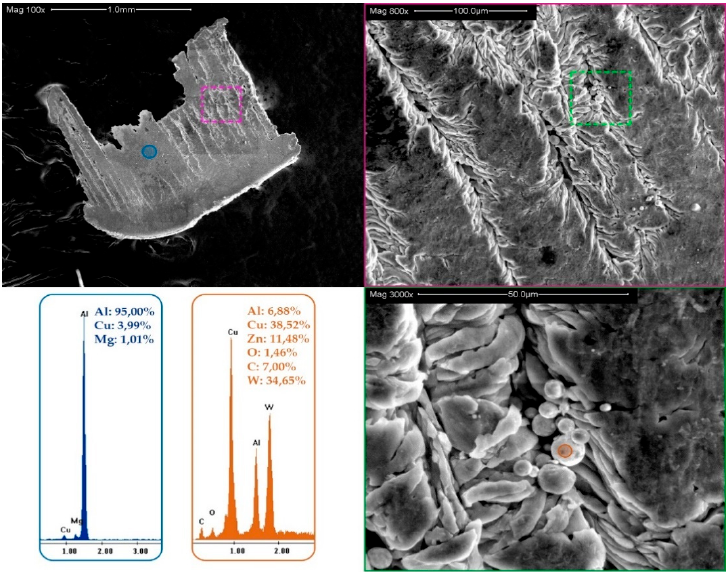
Figure 11. Analysis of the reverse face of the adhered material.